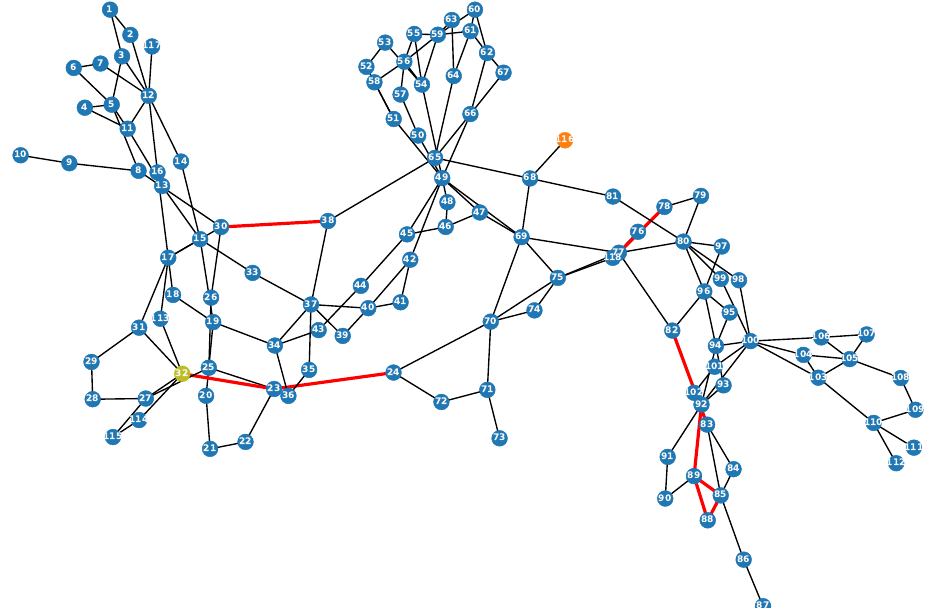
Figure 13. The optimal 1 × 150 MW RES and mobile MSSSC allocation during Season 1. Red lines indicate the mobile MSSSC deployment locations; light green node indicates the RES location without devices, and orange node indicates the RES location with